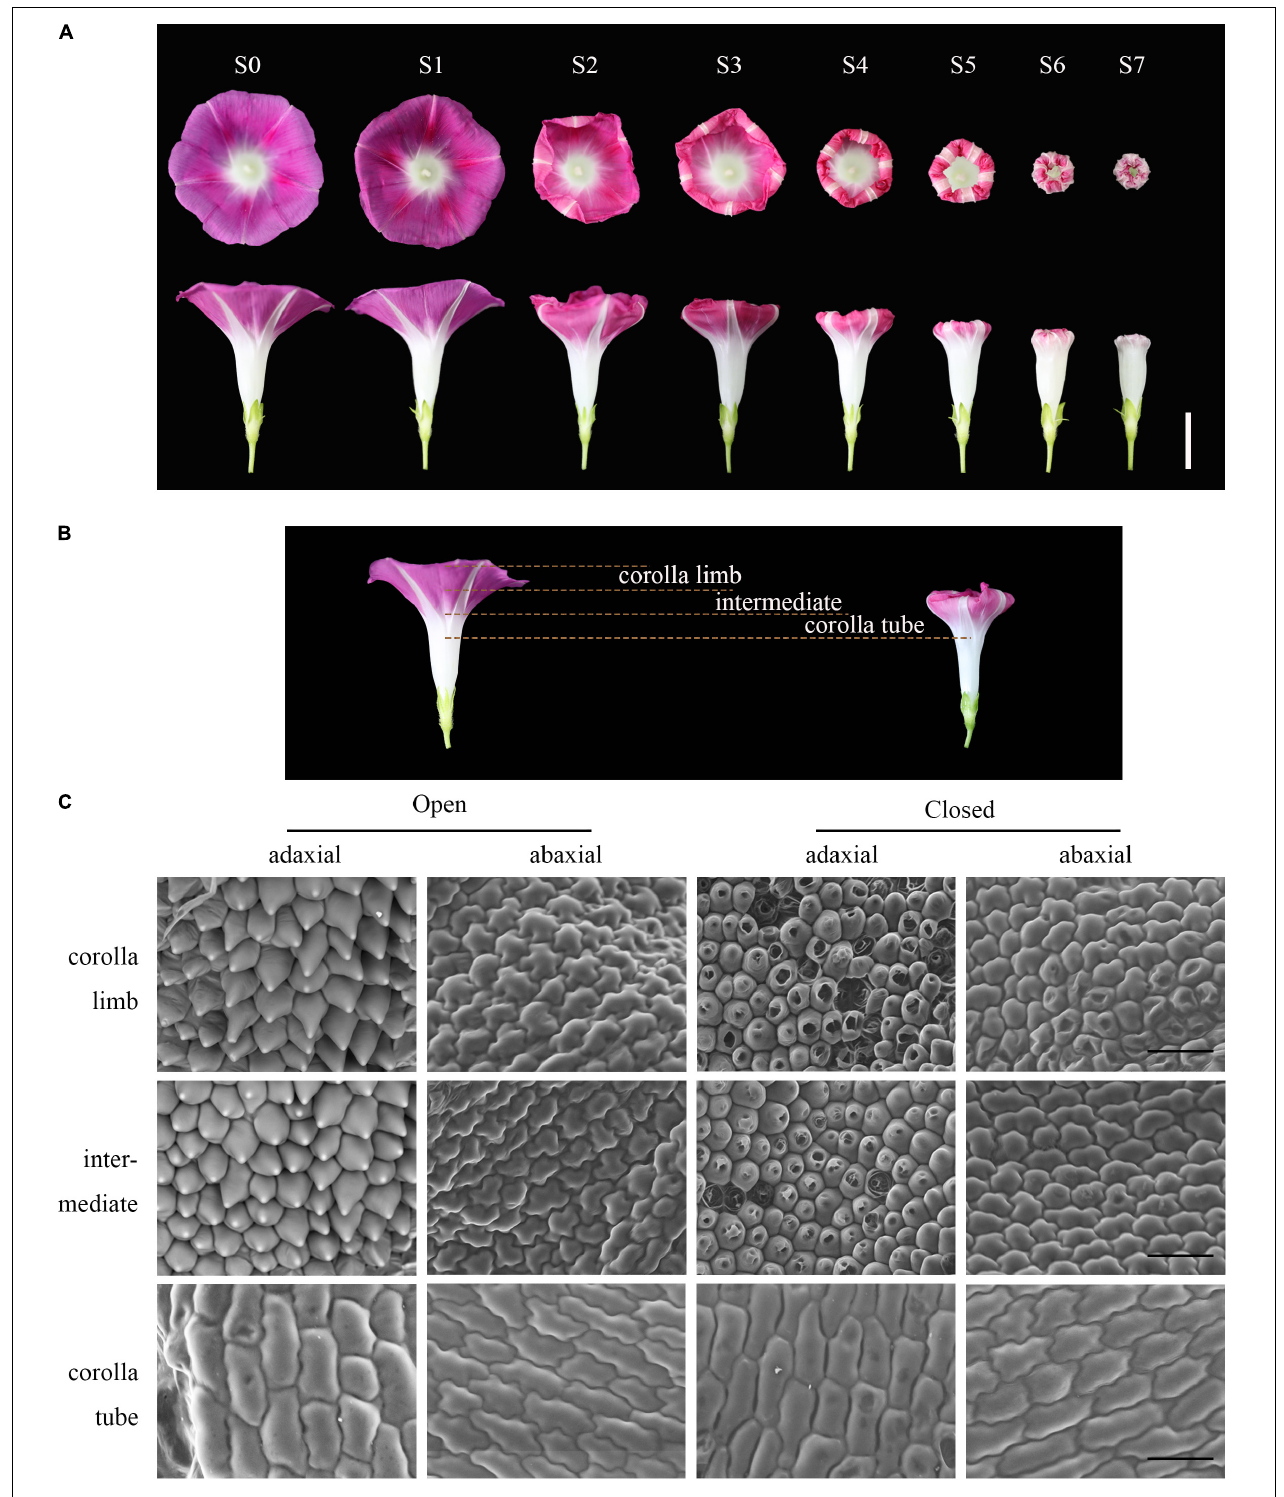
FIGURE 1 | The process and micromorphology of corolla closure. (A) The process of corolla closure was captured with a camera. S0–S1: full bloom stage; S2–S3: early corolla closure stage; S4–S5: late corolla closure stage; S6–S7: full corolla closure stage. The upper images were taken at a high angle and the lower images were taken from the side. Scale bar = 2 cm. (B) Longitudinal section of a corolla showing that several corolla layers were all responsive to movement. Yellow dotted lines mark the corolla limb, intermediate and corolla tube segments of the corolla. The intermediate corresponds to the junction between the corolla limb and tube. (C) Cell morphology of the adaxial and abaxial epidermis at different stages was tracked by SEM. Open: S1; Closed: S3. Scale bar = 50 µ m.